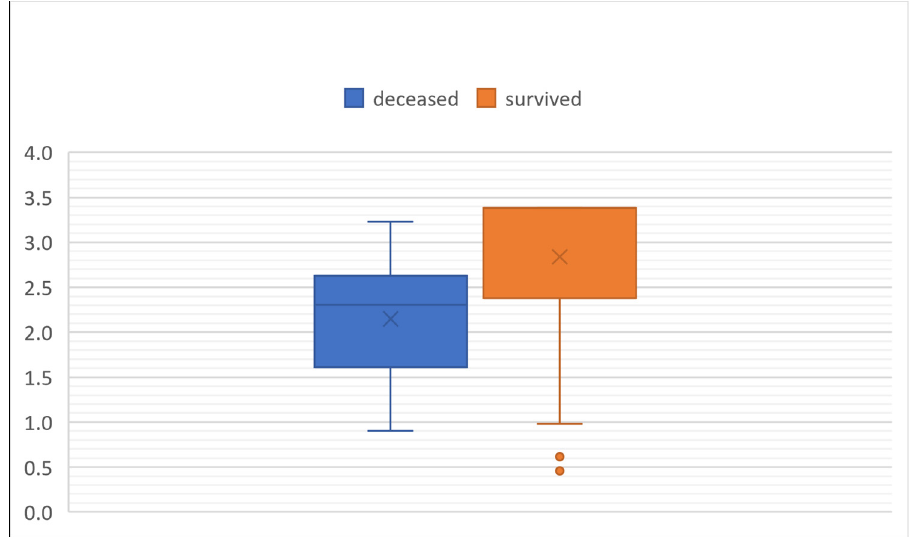
Figure 2. Comparison of the anti-CoV2S antibody level of the deceased and the surviving patients (n = 76). The mean level of antibodies at the time of hospitalization was lower in deceased patients (339.1 U/mL, blue) than it was in patients who survived (1481.8 U/mL, orange; p = 0.00152). For better visualization, the anti-CoV2S antibody level (U/mL) was converted to a decadic logarithmic scale. The blue boxplot demonstrates the level of the deceased patients and the orange one the level of the patients who survived.